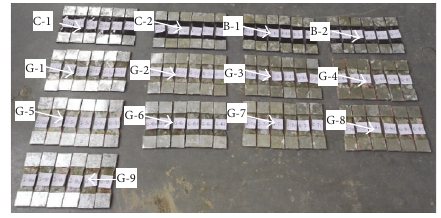
Figure 6: 13 groups of specimens.